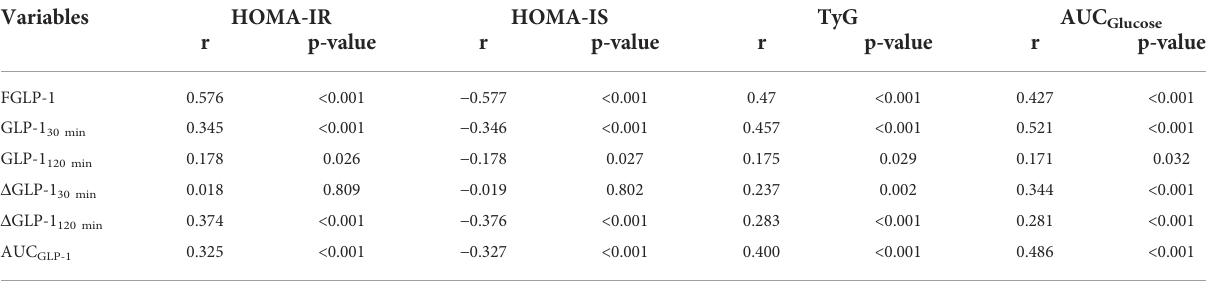
TABLE 4 Correlation analysis of GLP-1 with HOMA-IR, HOMA-IS, TyG, and AUC glucose.